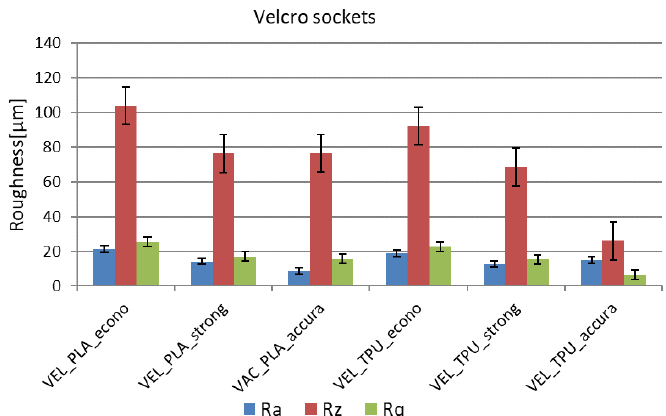
Figure 17. Roughness measurement results for the Velcro-fastened sockets.